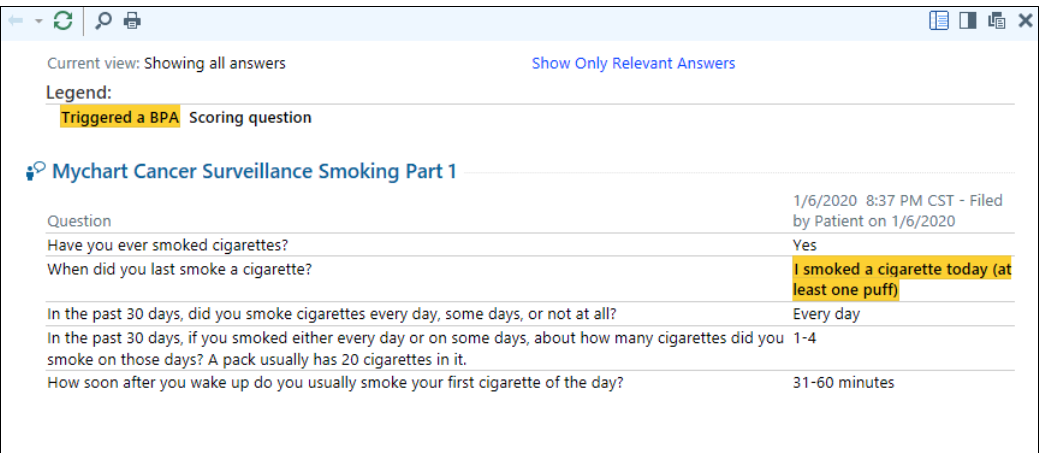
Figure 3. Provider and program view of a positive screen result. © 2020 Epic Systems Corporation. Used with permission.